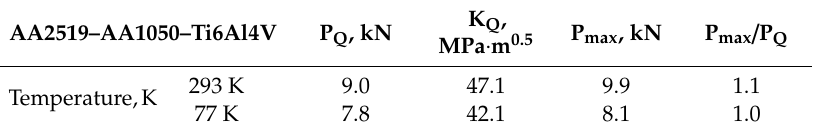
Figure 9. Diagrams of load–COD determined during the tests of the maximal experimental value of stress intensity factor K Q determined for the layered material AA2519–AA1050–Ti6Al4V under ambient and cryogenic conditions. Table 5. Results of fracture toughness tests in a linear-elastic range for AA2519–AA1050–Ti6Al4V layered material determined for cryogenic